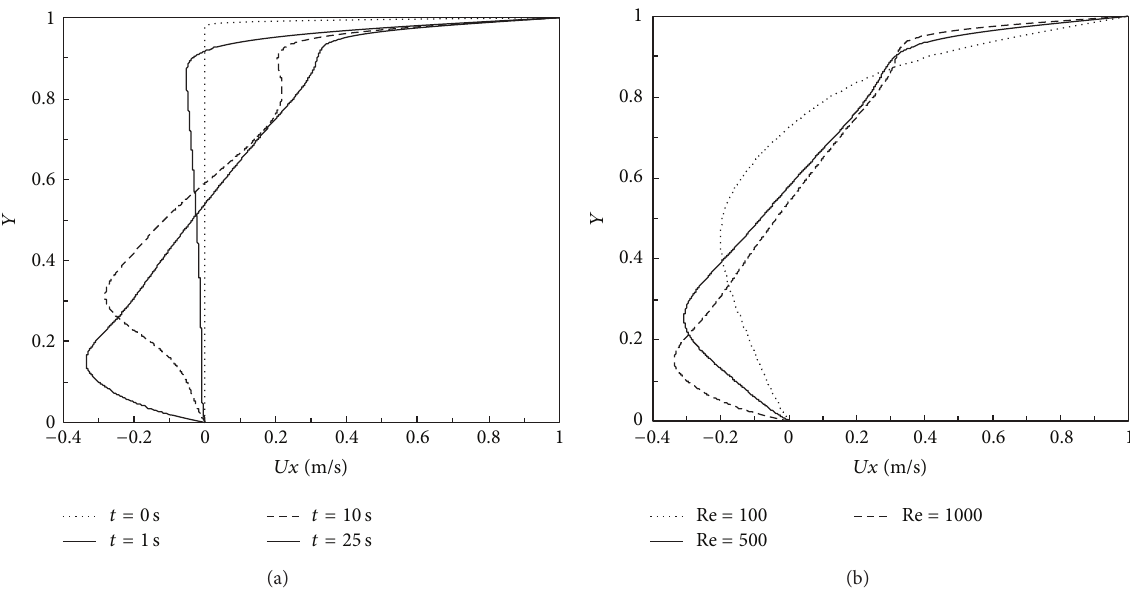
Figure 4: Ux velocity profiles along a vertical line in cavity flow; (a) the Ux velocity profiles at different time steps with Re = 1000 and (b) the Ux velocity profiles with different Reynolds numbers as Re = 100, 500, and 1000.